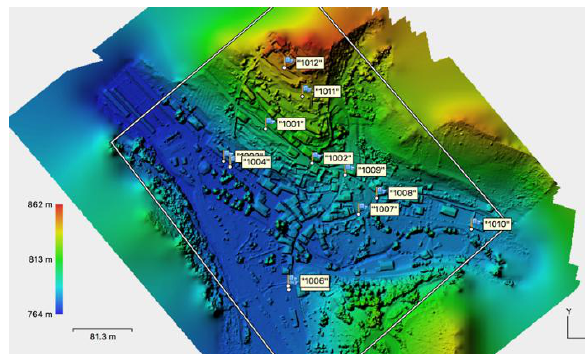
Figure 7. DEM of Castelsantangelo sul Nera